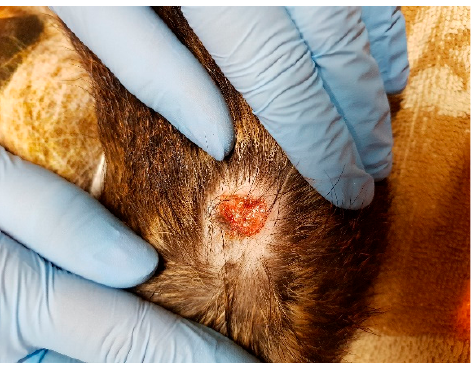
Figure 3. Visual record of a sore on one C. obscurus at MZ. Photograph taken while the animal was under general anaesthetic, MZ, 2019.